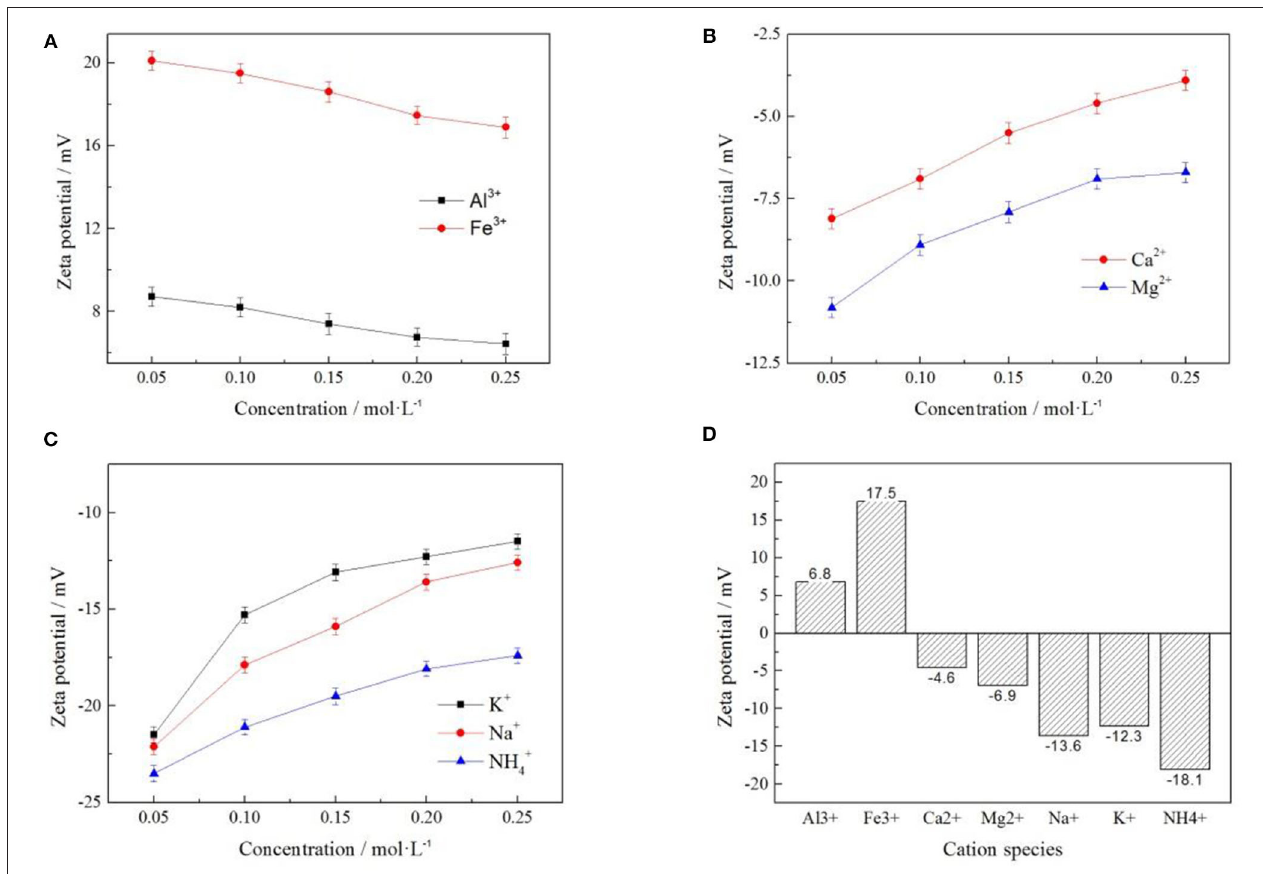
FIGURE 7 | Effect of cation concentration on zeta potential of clay minerals [where (A?C) represent + 3, + 2, and + 1 valence cations respectively, (D) represents the zeta potential of clay minerals when the concentration of various cations was 0.2 mol/L].